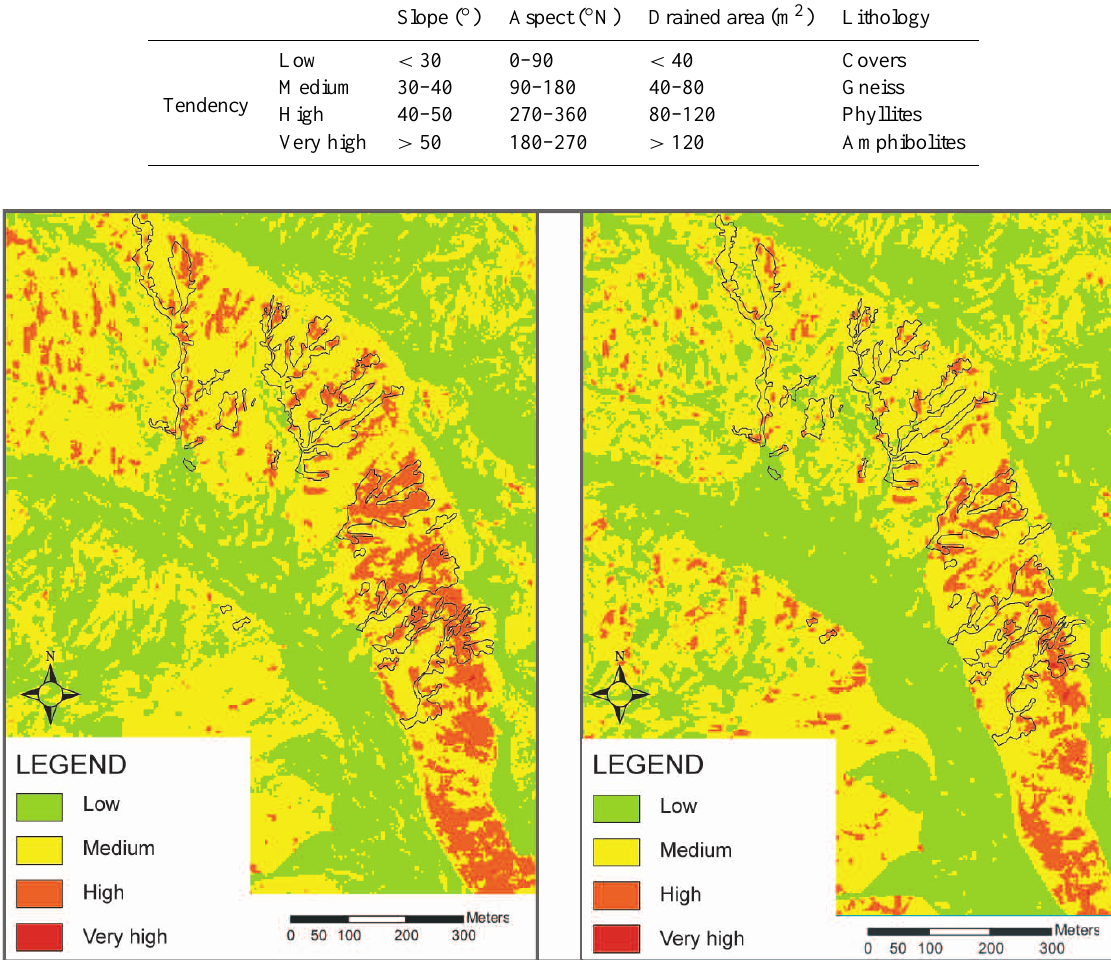
by the local destruction of terraces contained by stone walls, becoming exceptionally dense and characterised by a very high destructive